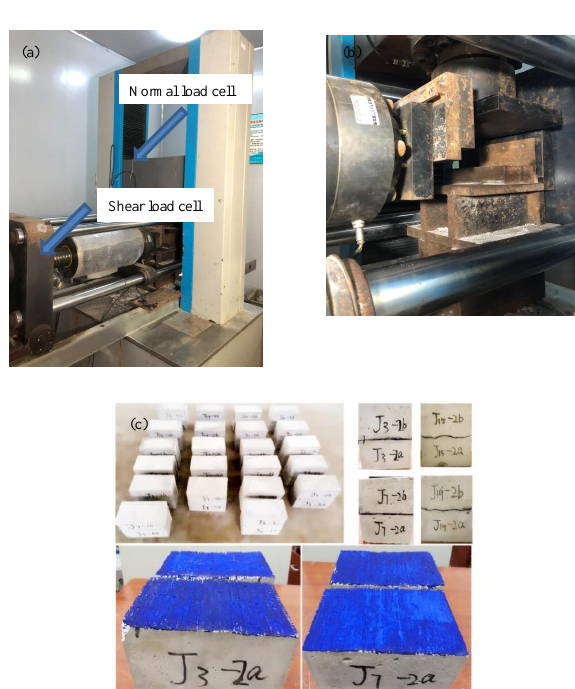
Fig.2. (a)-(b) RYL-600 Rock mechanics shear rheometer; (c) Part of the specimens. Figure 2: (a)–(b) RYL-600 Rock mechanics shear rheometer; (c) Part of the